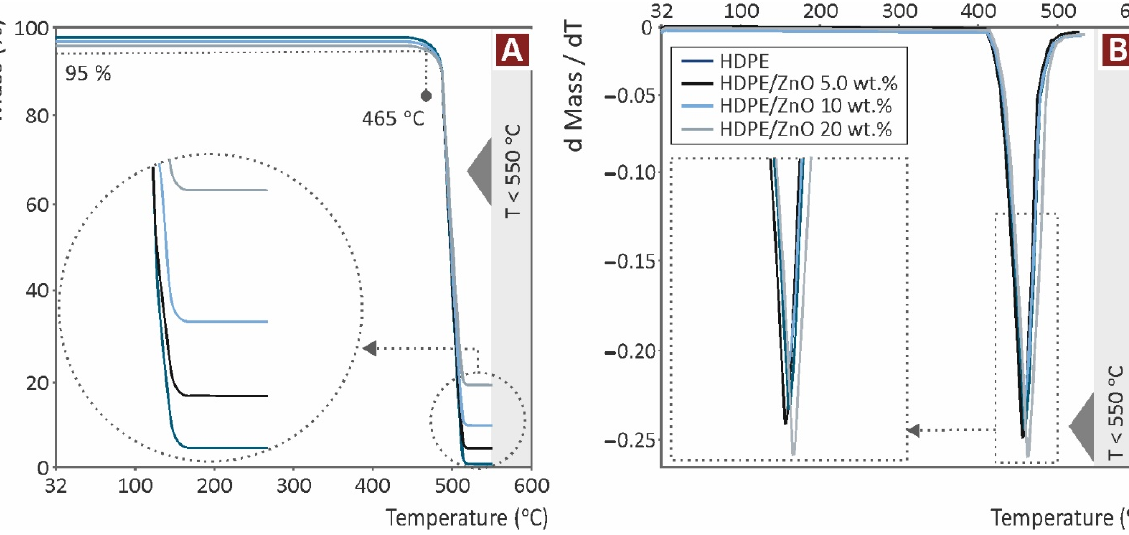
Figure 5. ( A ) TGA graphs of unfilled HDPE thermoplastic and HDPE with ZnO composites; and ( B ) Weight loss rate graphs compared to temperature for unfilled HDPE thermoplastic and HDPE with ZnO composites.